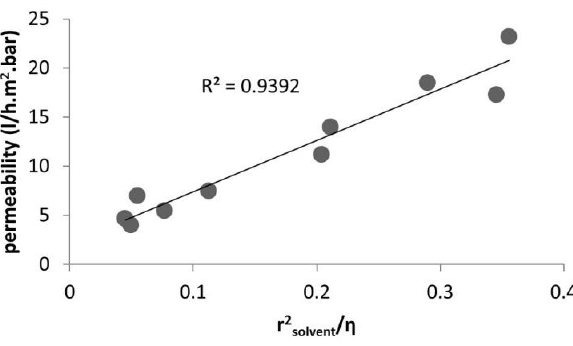
/ η studied by solvent